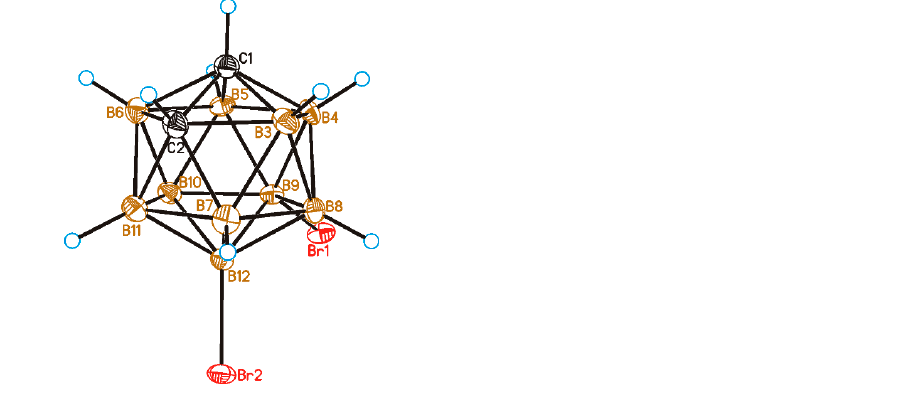
Figure 1. General view of 9,12-Br 2 - ortho -C 2 B 10 H 10 showing atomic numbering. Thermal ellipsoids are drawn at 50% probability level.